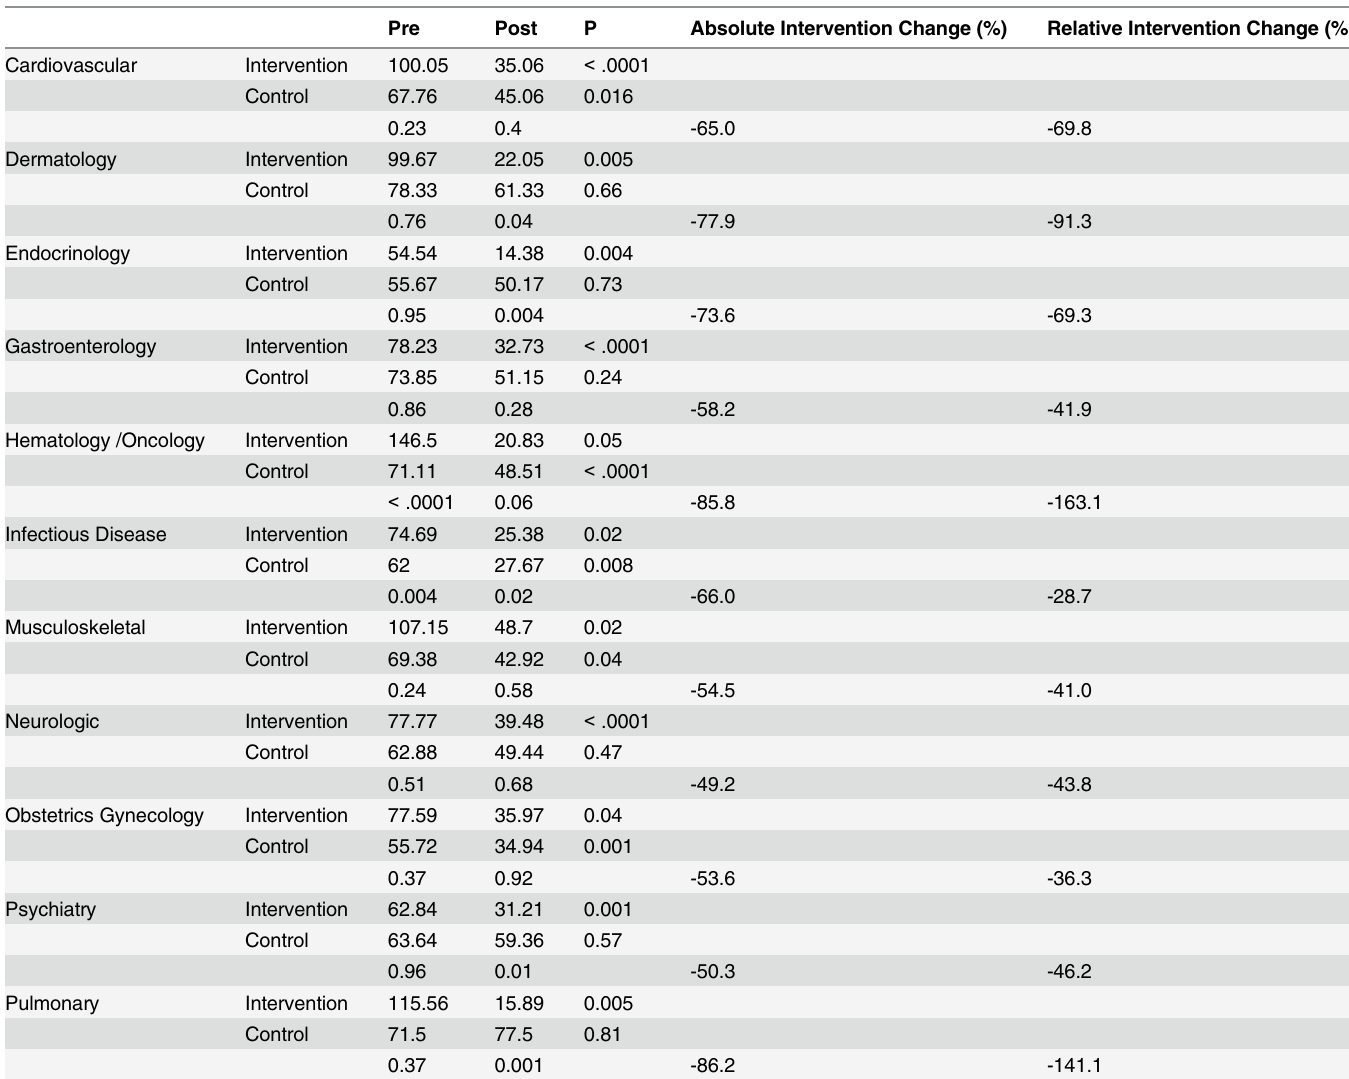
Table 5. Disease Category: High Control Utilization subgroup vs Intervention